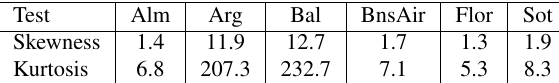
Table 5: Coefficient of skewness and kurtosis of the HRMS vari- able shape 2